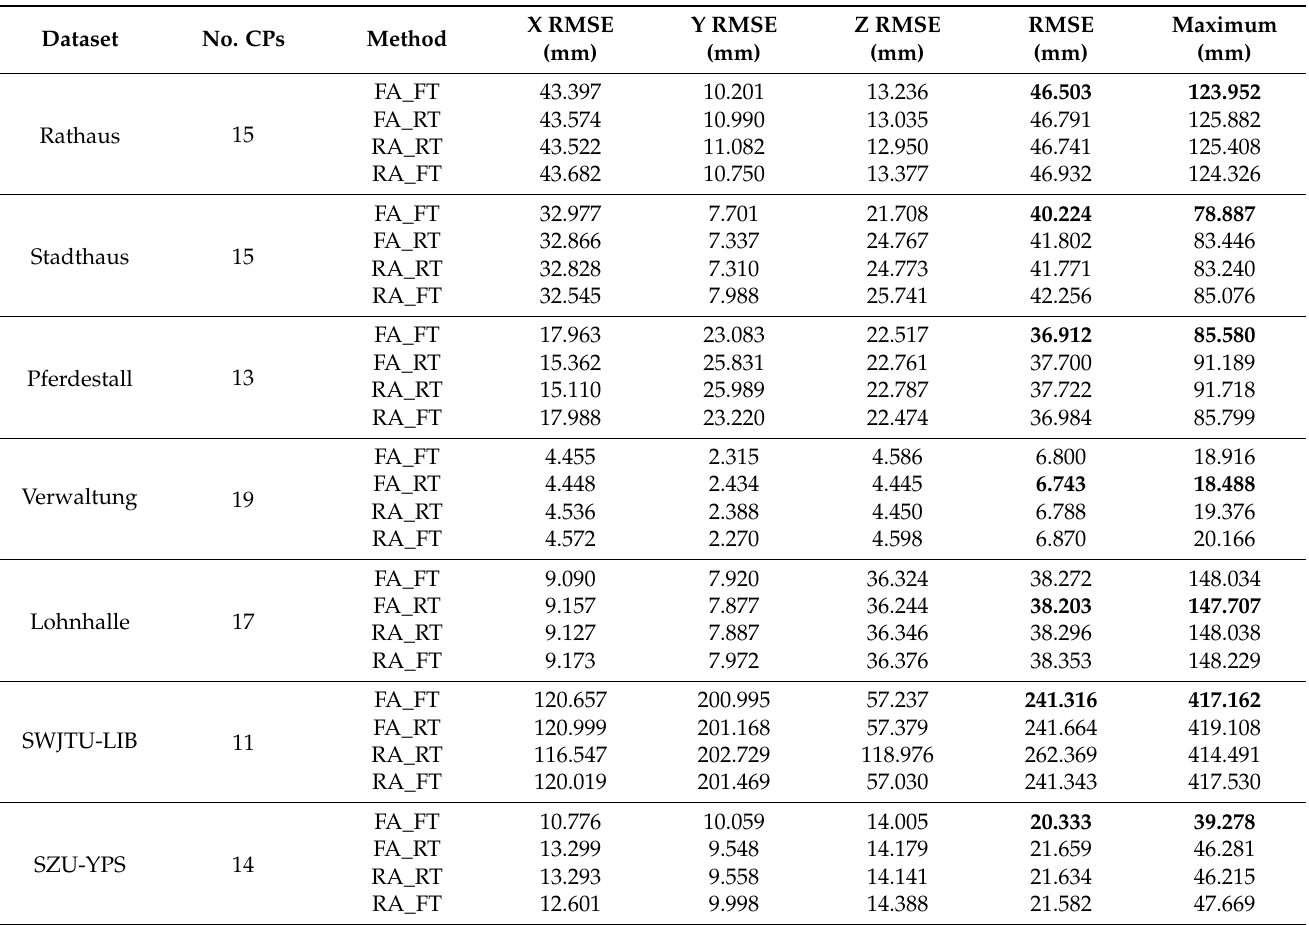
Table 10. Statistics of checkpoints. No. CPs: number of checkpoints. RMSE: root mean square error. The values in bold indicate the minimal values in the compared four